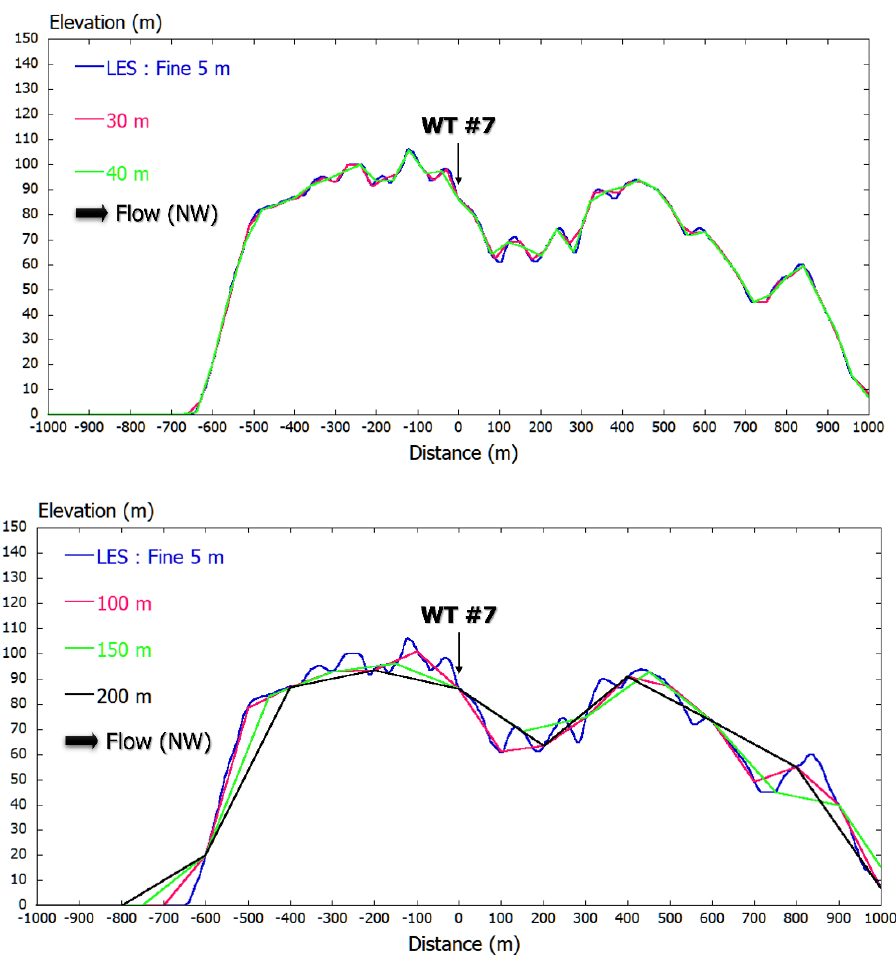
Figure 33. Comparison of terrain shapes passing through WT #7 for north-westerly wind—5 m, 30 m, 40 m, 100 m, 150 m, and 200 m.